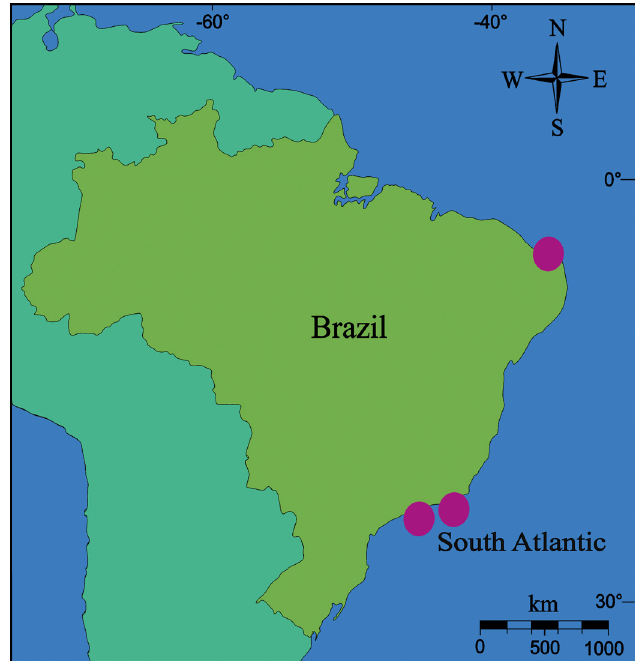
Figure 14. Distribution of Excorallana subtilis (Hansen, 1890) for Brazilian